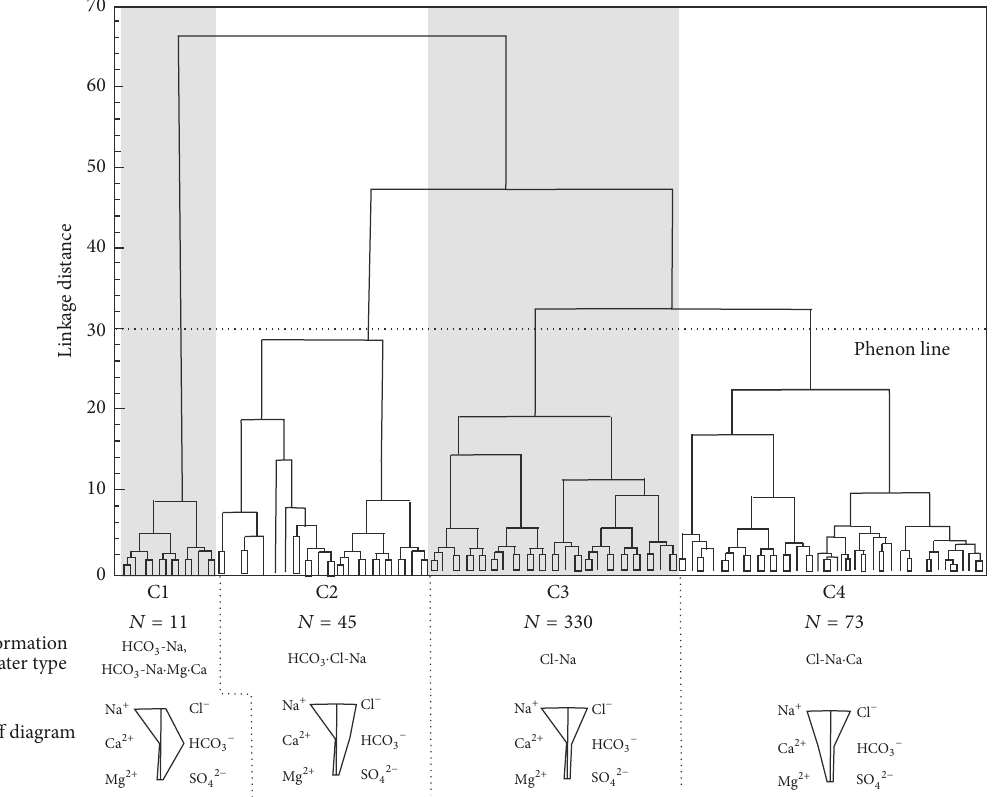
Figure 5: Dendrogram for the formation water samples in buried hill of Jizhong Depression, showing the division into four clusters and the median concentration Stiff diagram of each cluster.